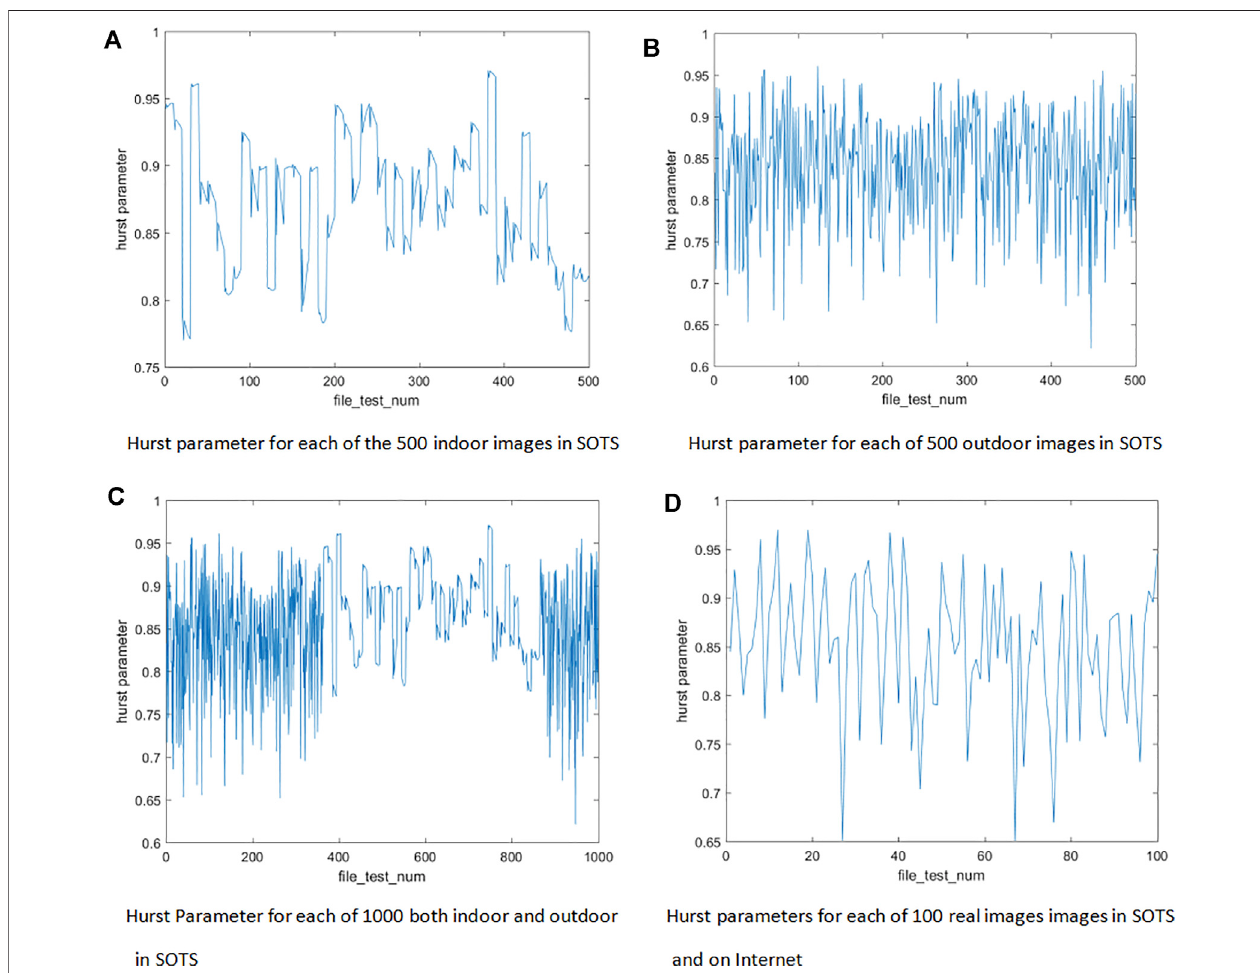
FIGURE 2 | Plots of H of four foggy image